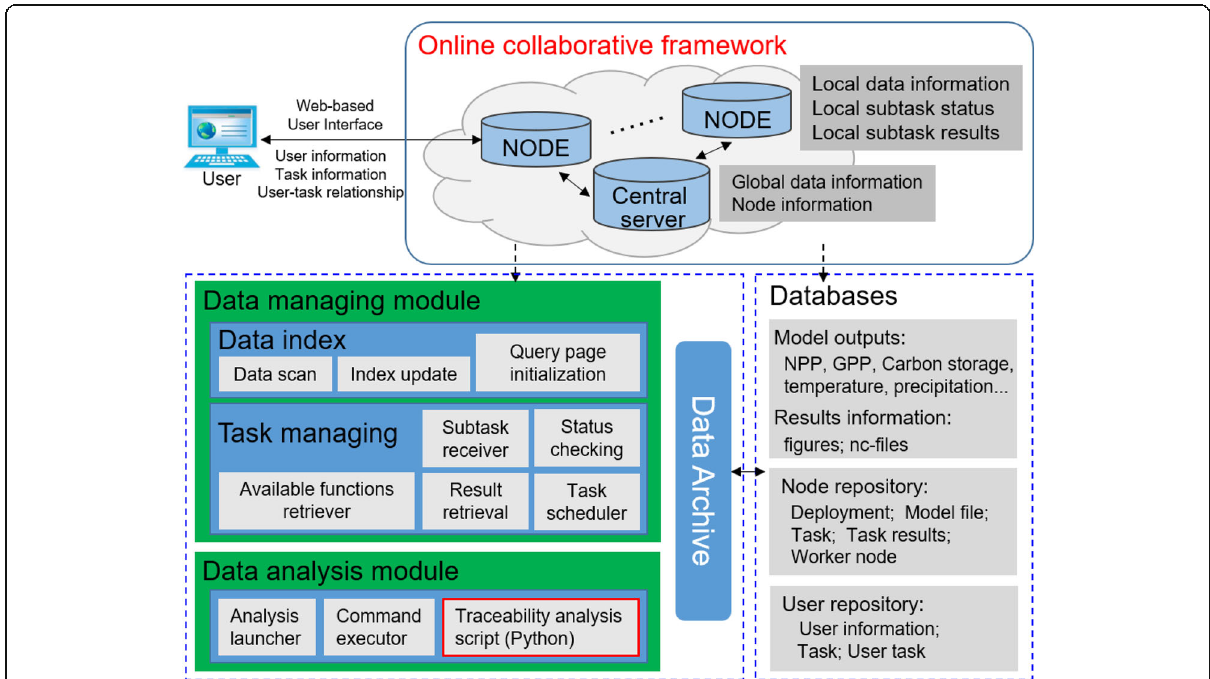
Fig. 1 Schematic overview of TraceME (v1.0). The online collaborative framework of TraceME (v1.0) consists of one central node (Central server) and several work nodes (NODE). Users trigger the tasks of model evaluation through the browser and the tasks can be transferred by the application-programming interface. The work nodes consist of the data managing module, the data analysis module, and the data archiving function. The central node collects all information about the work nodes, the data stored in those nodes, and the information of the